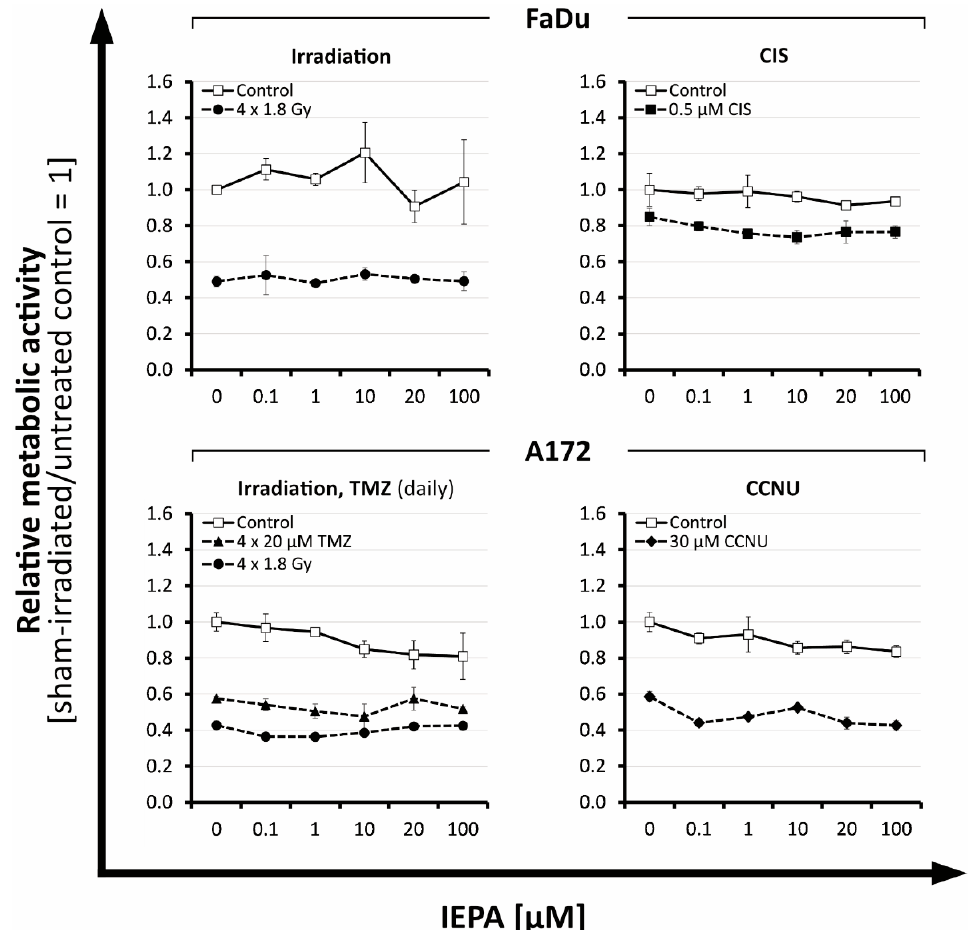
Figure 1. Relative effects of IEPA compared with sham-treated control on the metabolic activity of tumor cell lines FaDu and A172 after fractionated IR or treatment with different cytostatic agents at ID 50 /IC 50 . Data represent single experiments, except for fractionated control in A172 (n = 2). Experiments were performed in duplicates; mean ± SEM.